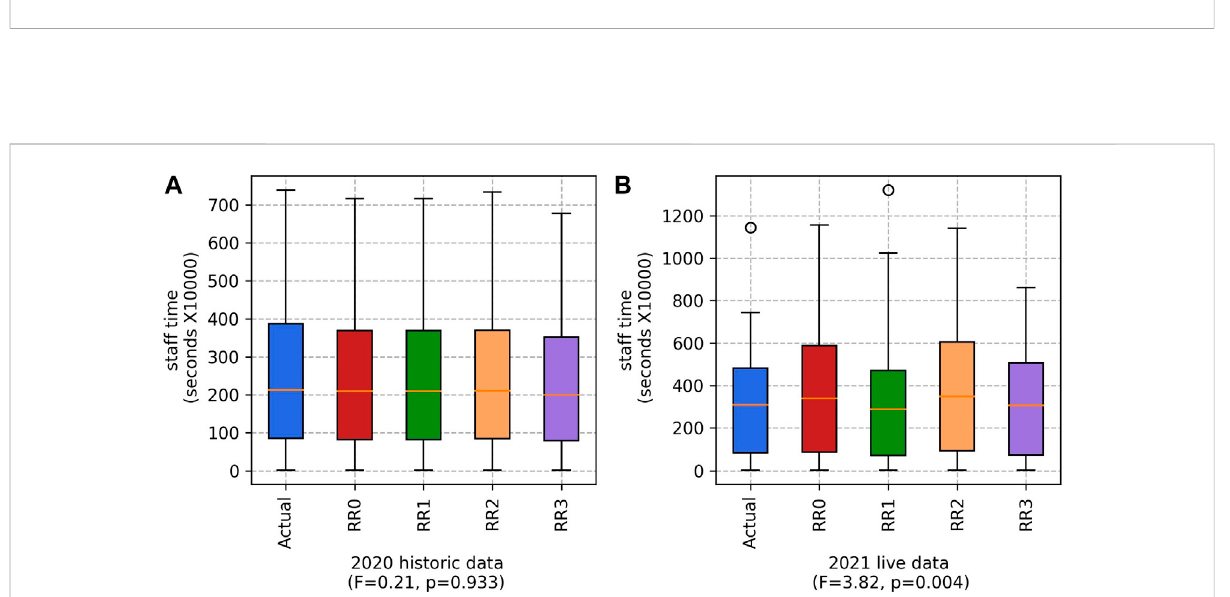
FIGURE 4 Staff time for the Actual teams and our four RR variants (RR0, RR1, RR2 and RR3), based on (A) 2020 historic data and (B) 2021 live data. (Lower values are